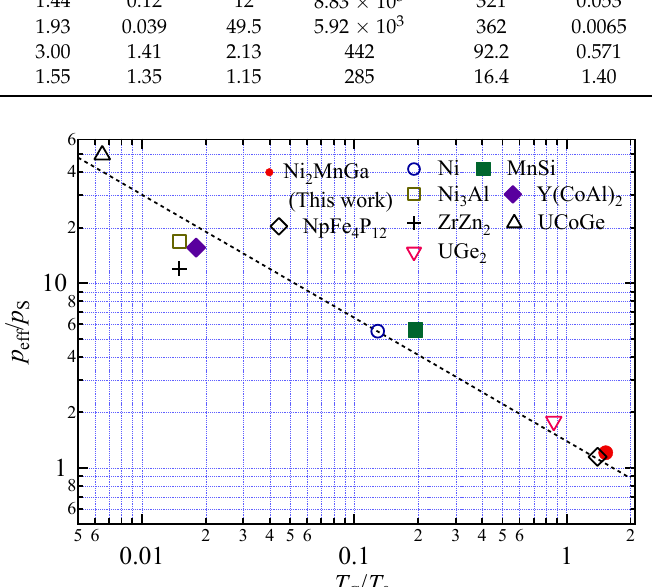
Figure 5. The generalized Rhodes-Wohlfarth plot (double logarithmic plot of p eff / p S and T C / T 0 ) for Ni 2 MnGa and other notable alloys and compounds. The dotted line indicates k m = 1.4 as obtained from Equation (10).